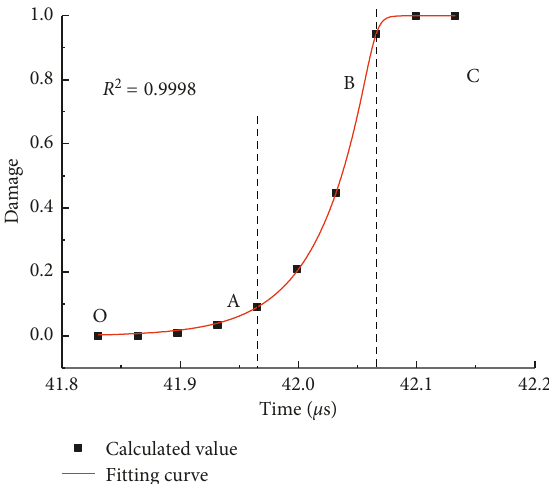
Figure 15: The fitting curve of damage-time in the air-filled specimen at 45 ° and L � 20mm.